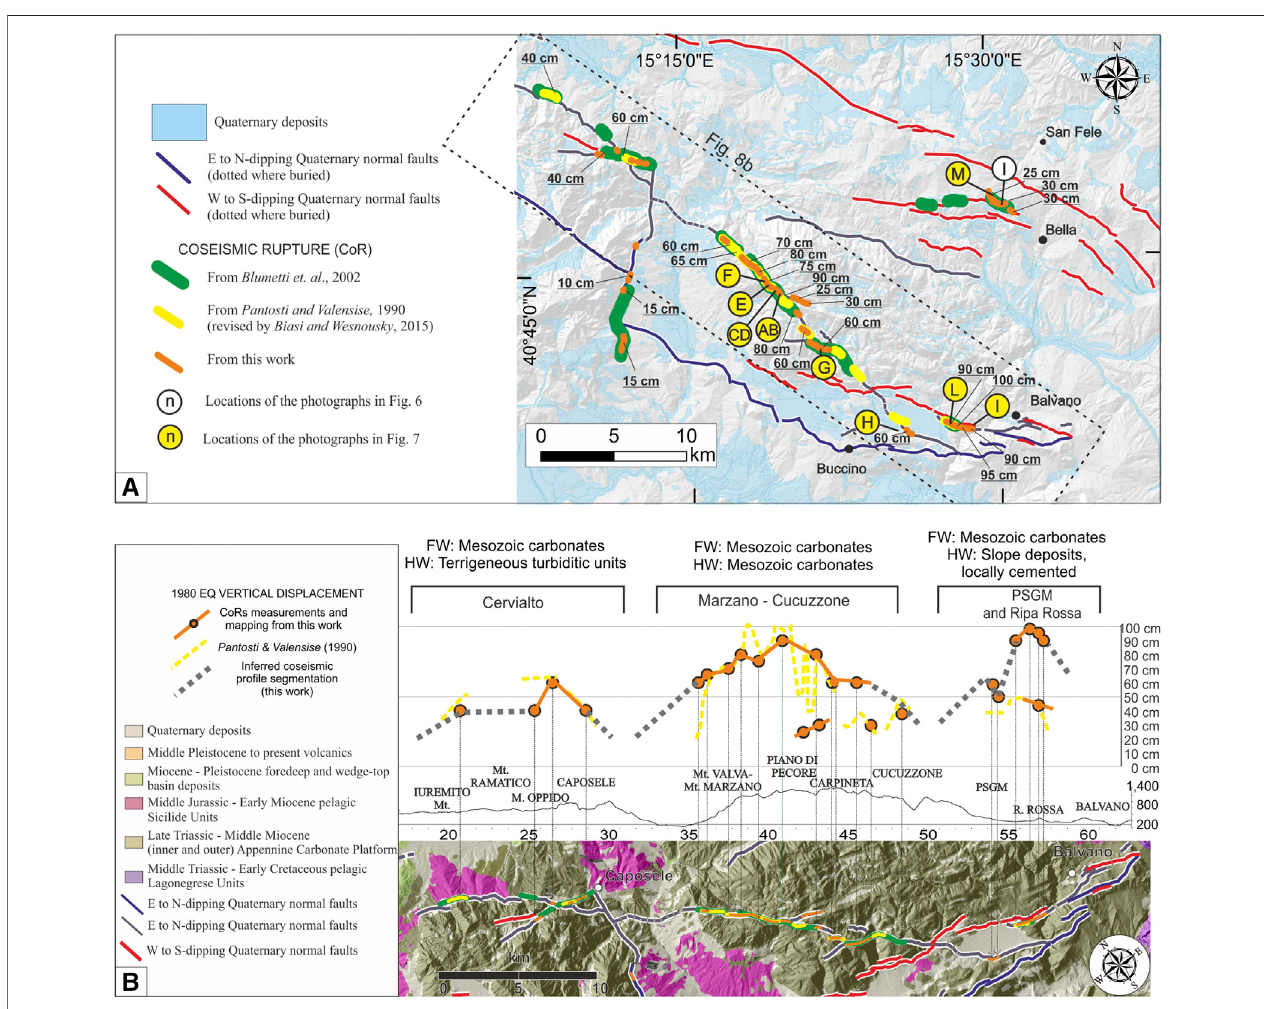
FIGURE8| Representationandanalysisof1980coseismicdata (A) SchematicstructuralmapofthestudyareaonwhichtheQuaternarydepositsarerepresented in light-blue on a 10 m resolution DEM. Along the traces of the main faults, the vertical displacement (in centimeters) of the CoRs measured during our fi eldwork are reported. The extent along the strike of the CoRs is represented through colored ribbons according to the authors who mapped them (explained in the legend). Yellow circles are thelocations ofthe photographs of Figure 7 . (B) The graphics isa comparison between CoRs mapped in this work (orange linesand circles)and CoRs mapped by Pantosti and Valensise (1990) (yellow dashed lines) reported in map view through the topographic pro fi le on the trace of IF. A schematic summary of the geologic contacts between the hanging wall and the footwall of the CoRs along the different segments is reported.